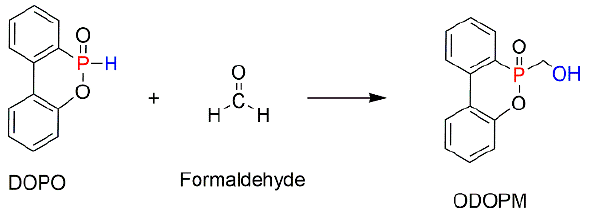
Figure 20. Synthesis of 2-(6-oxido-6H-dibenz[c,e][1,2]oxaphosphorin-6-yl)methanol (ODOPM) from DOPO [48,113,114].